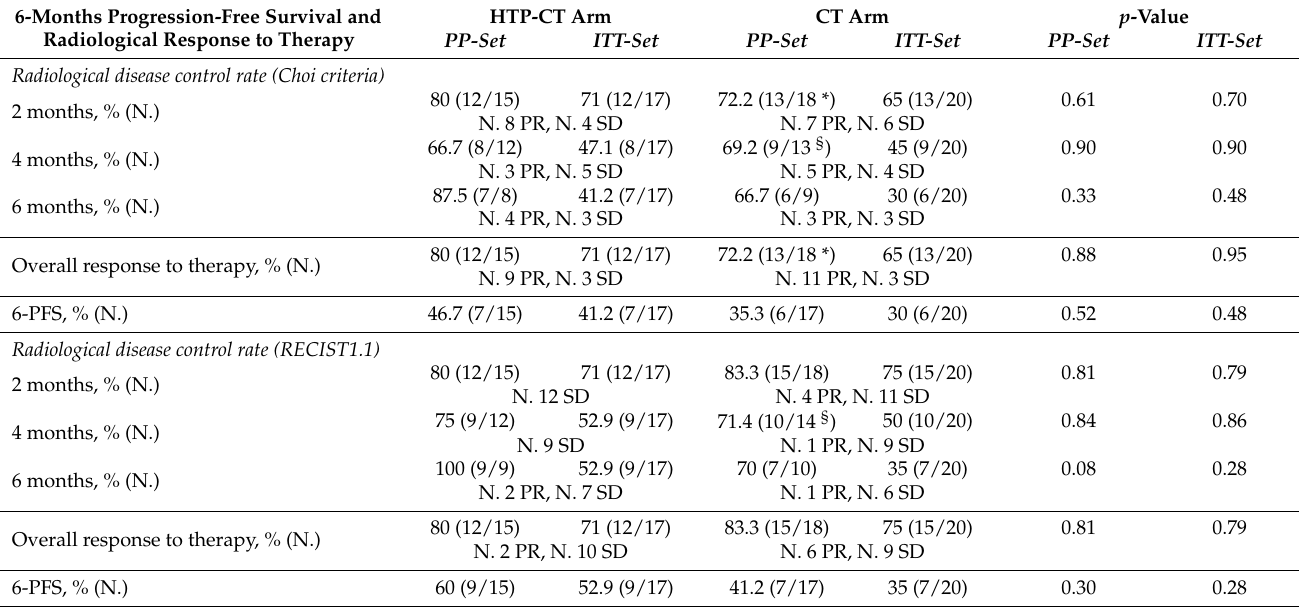
Table 2. Rates of radiological disease control (partial response + stable disease) at 2-, 4- and 6-months restaging, according Table 1. Patients experiencing progression disease at a restaging time-point were excluded from the analysis of the radiological response at the subsequent restaging time-point.